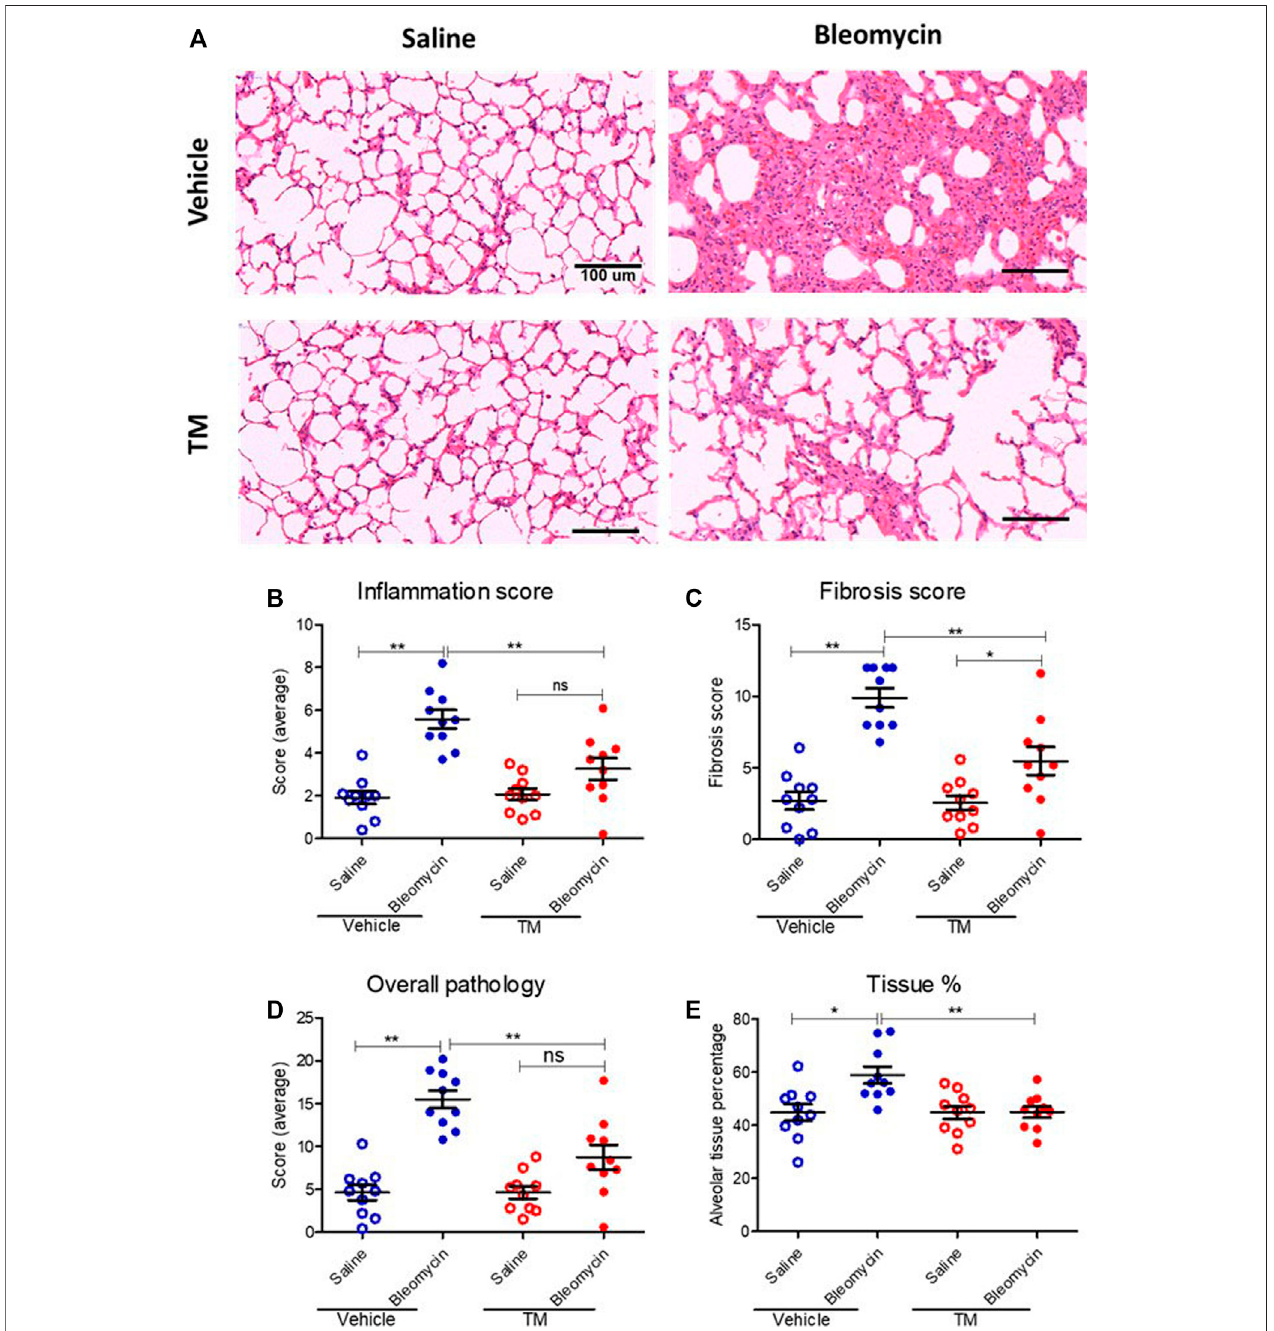
FIGURE 7 | Histopathology changes in differentially treated lung tissue sections. (A) Representative photomicrographs of H and E-stained histological tissues in saline- or bleomycin-infused segments treated with either TM or vehicle. Pathology was quanti fi ed with a semiquantitative scoring system shown in (B) in fl ammation score only, (C) fi brosis score only, (D) overall pathology. (E) Graph showing tissue percentage in all differentially treated lung tissue sections. *p < 0.05, **p < 0.01. ns (cid:1) not signi fi cant. Data represent mean ( ± SEM). Scale bars (cid:1) 100 µm.